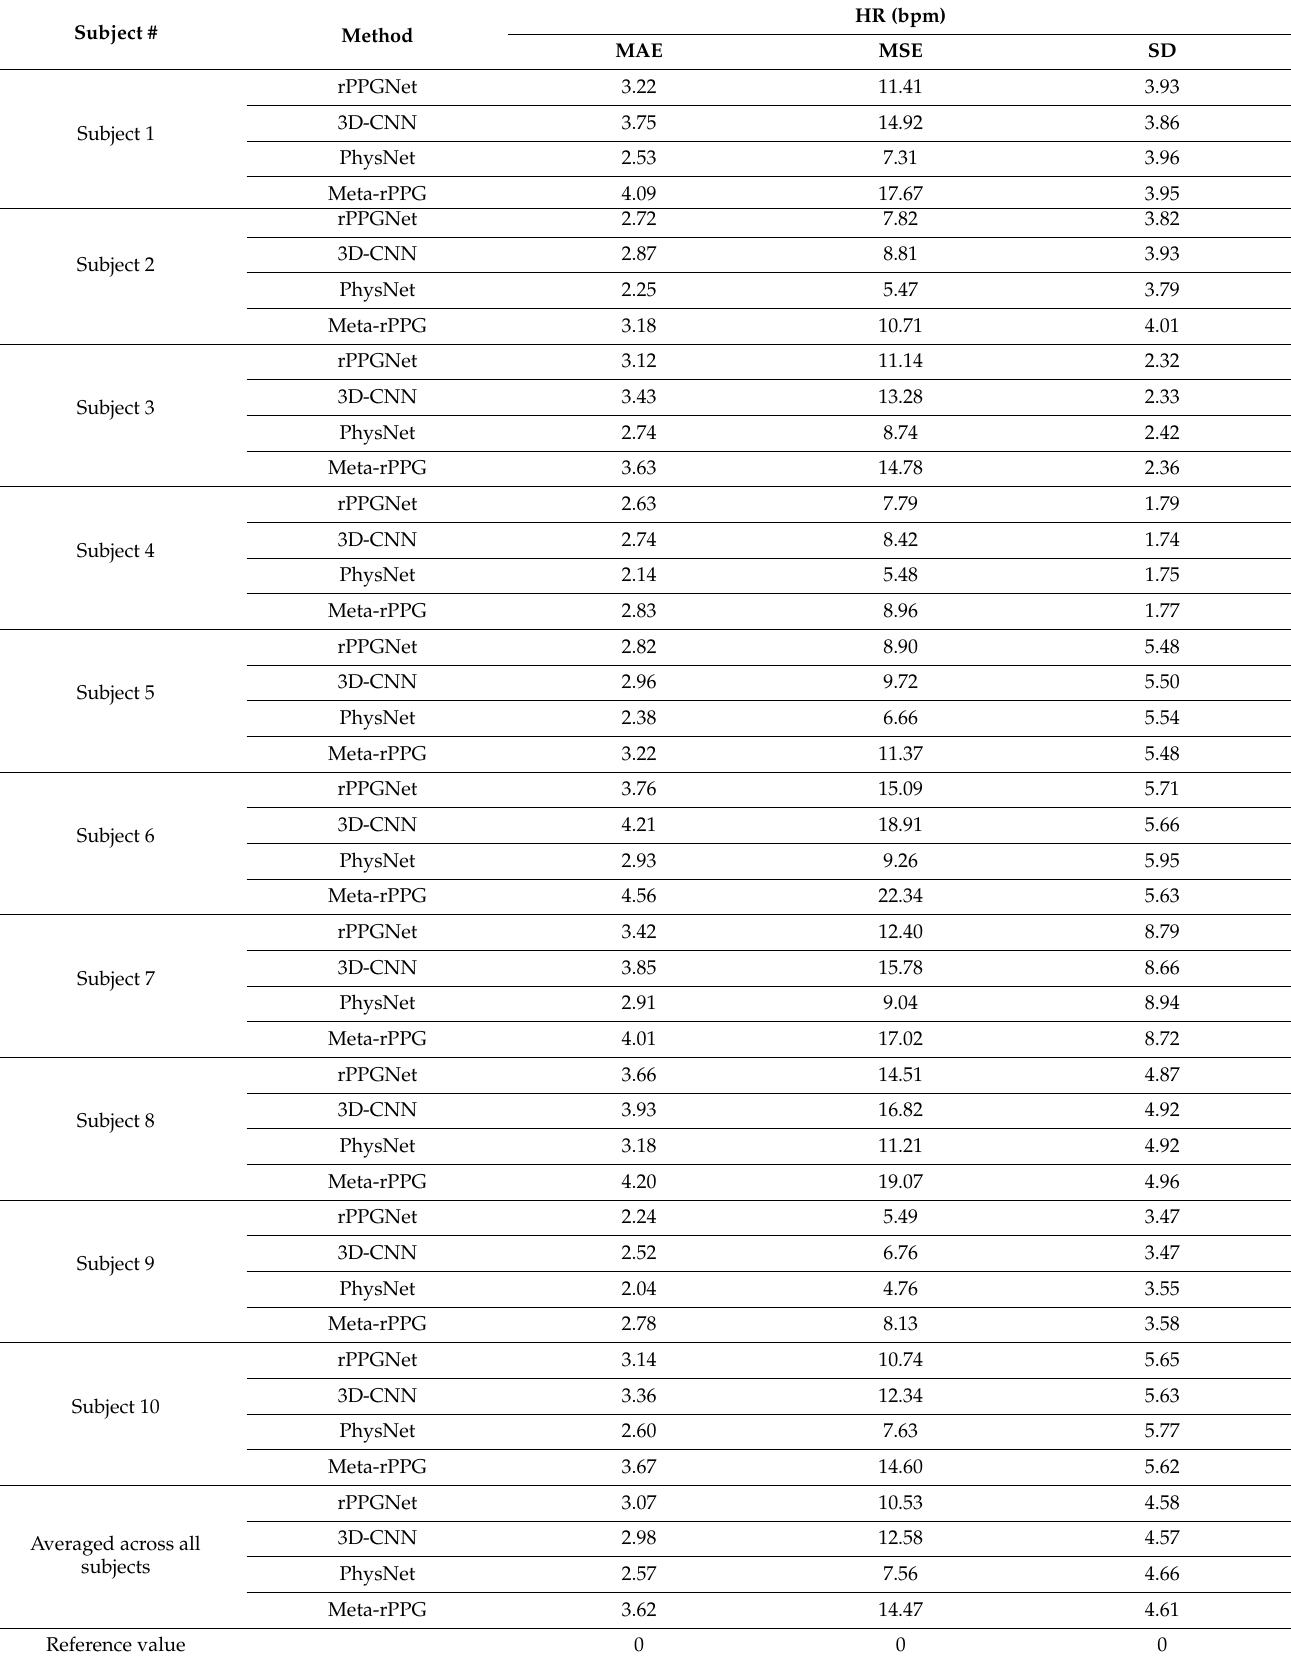
Table 5. Objective metrics for the four compared deep learning